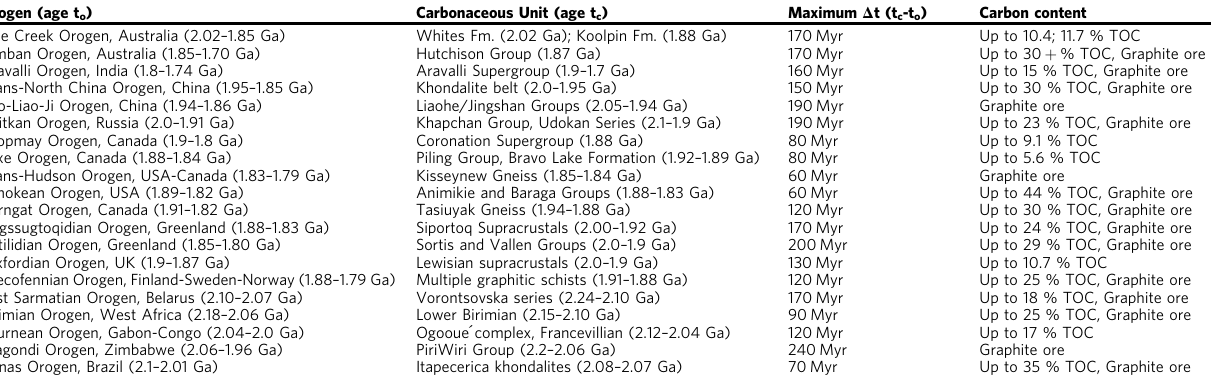
Table 1 Carbon contents of carbonaceous units which accommodated deformation in orogens. Orogen (age t o )